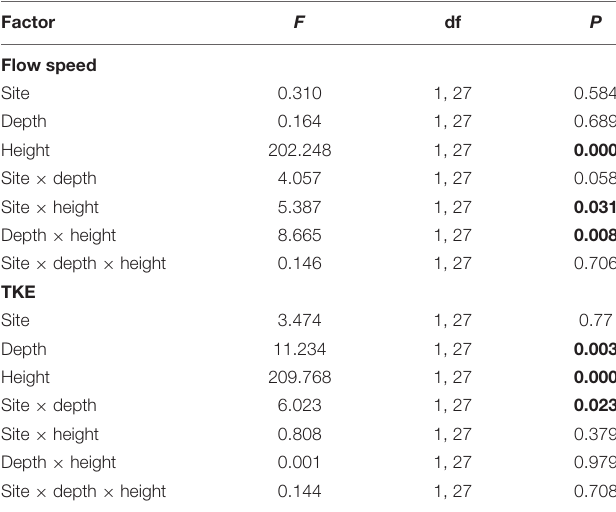
TABLE 1 | Three-way ANOVA of the effects of site (Ninepin Point and Tinderbox), depth (3 and 6 m) and height (within canopy and above canopy) on square root transformed factors flow speed and